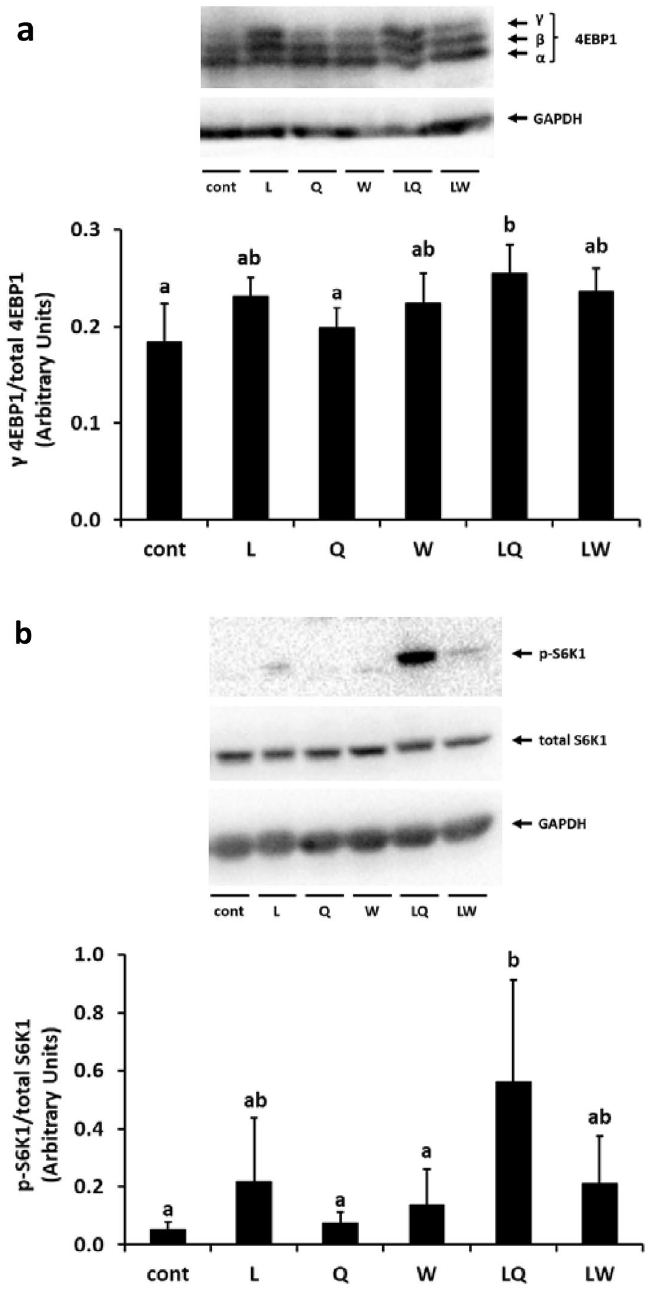
Figure 1. Changes in phosphorylation of 4EBP1 ( a ) and S6K1 at Thr389 ( b ) in the gastrocnemius muscle of mice administered 0.2% xanthan gum solution (Cont), leucine (L), glutamine (Q), tryptophan (W), leucine + glutamine (LQ), or leucine + tryptophan (LW) by gavage after 24 h fasting. On sodium dodecyl sulfate– polyacrylamide gel electrophoresis, 4EBP1 separated into multiple bands according to phosphorylation status. The highly phosphorylated form, γ form, exhibited the slowest mobility. Total 4EBP1 was calculated as the sum of the three bands. Densitometry results are expressed as the mean ± standard deviation (SD) (n = 5). a,b Mean values denoted by different letters represent significant differences between the groups (P < 0.05). The original blots are presented in Supplementary Figs. S1 and